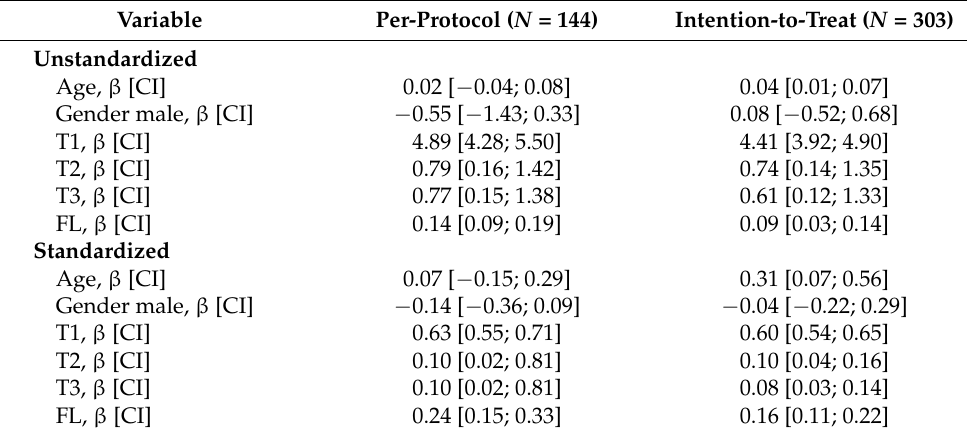
Table A3. Regression coefficients for model 2, with DI as